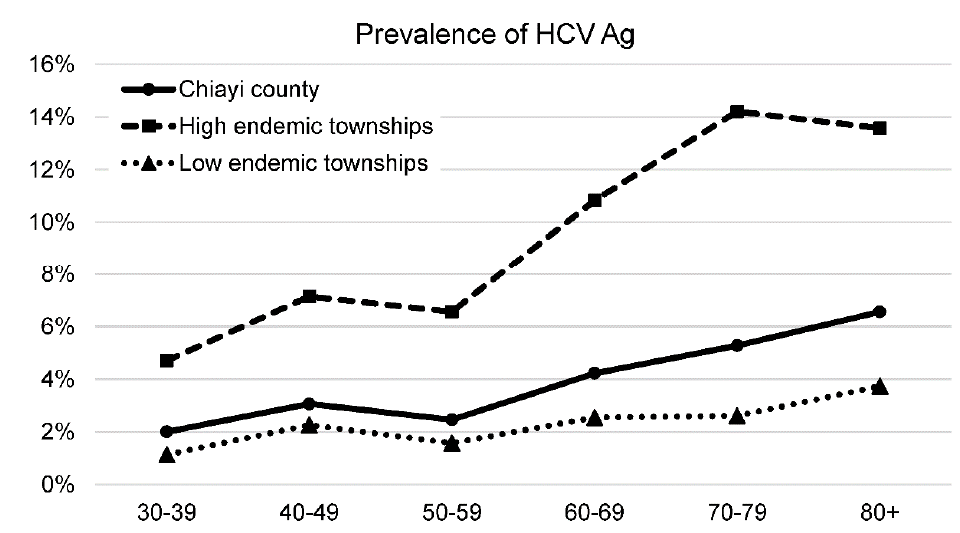
Figure 3. Age − specific prevalence of HCV Ag by endemicity of HCV. Table 3. The age and sex of HCV Ag-positive patients detected in this screening by Direct-acting Antiviral Agents (DAA)